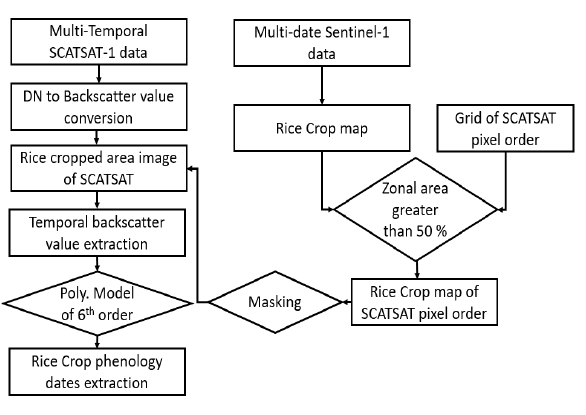
Figure 1: Methodology Followed